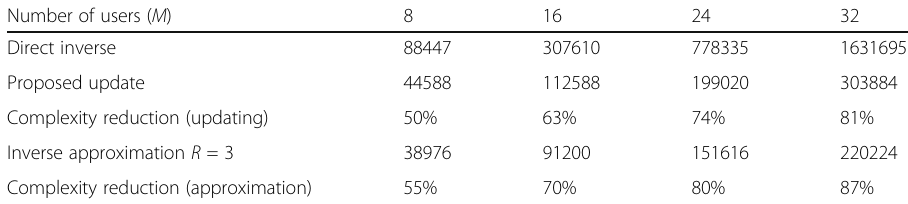
Table 3 Numbers of complex-valued operations required for the ZF STBC decoder: a user is removed from the system Number of users ( M